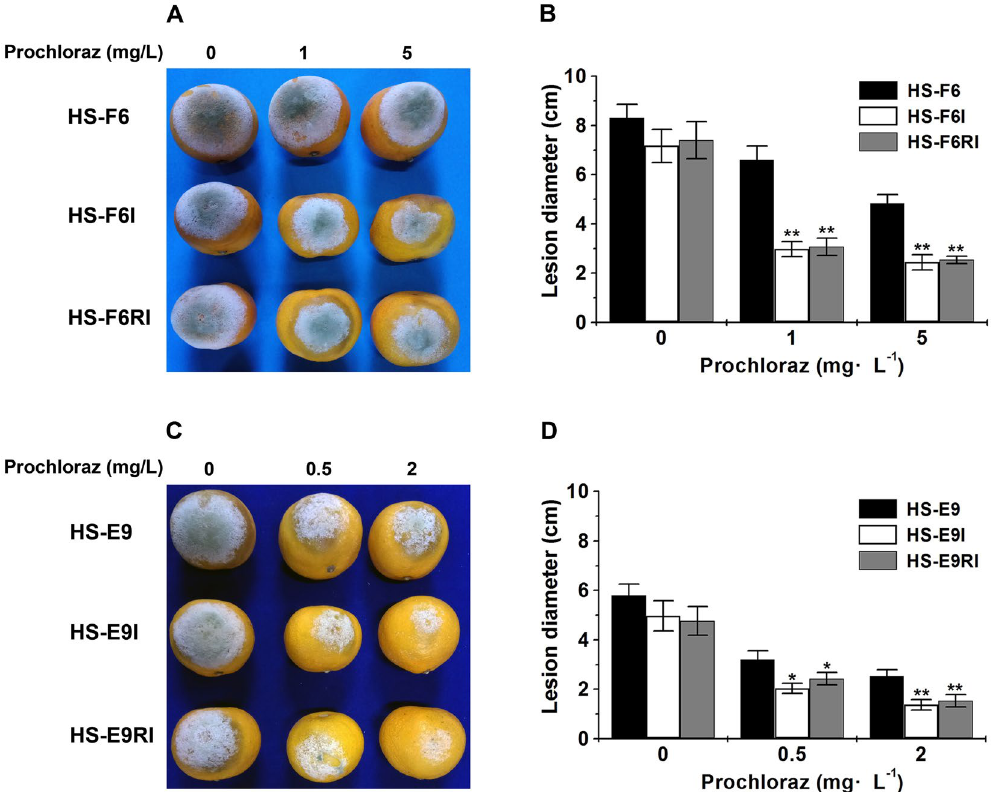
Figure 5. Biological effects of PdPmV1 and PdNLV1 coinfection on P. digitatum strains HS-F6 and HS-E9. ( A ) Virulence for HS-F6 and its virus-infected strains (HS-F6I and HS-F6RI) on the prochloraz-treated citrus peel (prochloraz concentrations: 0, 1 and 5 mg·L − 1 ). The inoculated citrus fruits were incubated for 5 d at 25 °C. ( B ) Bars representing the mean lesion diameter of the virulence assay plus standard errors of three cultures are shown in panel A ( ** P < 0.01). ( C ) Virulence for HS-E9 and its virus-infected strains (HS-E9I and HS-E9RI) on the prochloraz-treated citrus peel (prochloraz concentrations: 0, 0.5 and 2 mg·L − 1 ). The inoculated citrus fruits were incubated for 5 d at 25 °C. ( D ) Bars representing the mean lesion diameter of the virulence assay plus standard errors of three cultures are shown in panel C ( * P < 0.05; ** P <